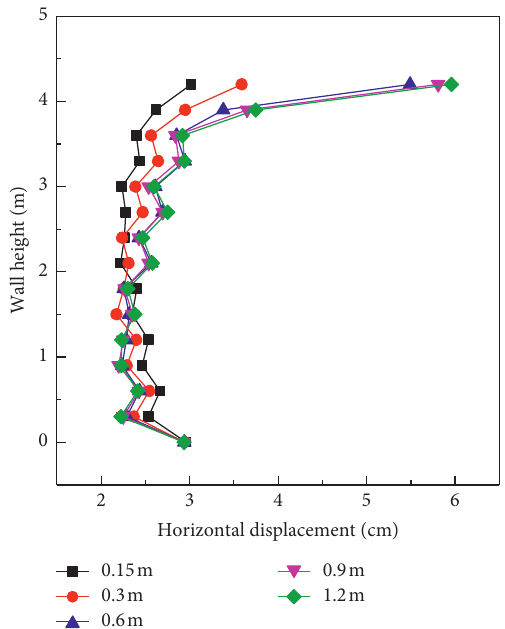
Figure 14: Horizontal displacement of the retaining wall under different geocell spacings.